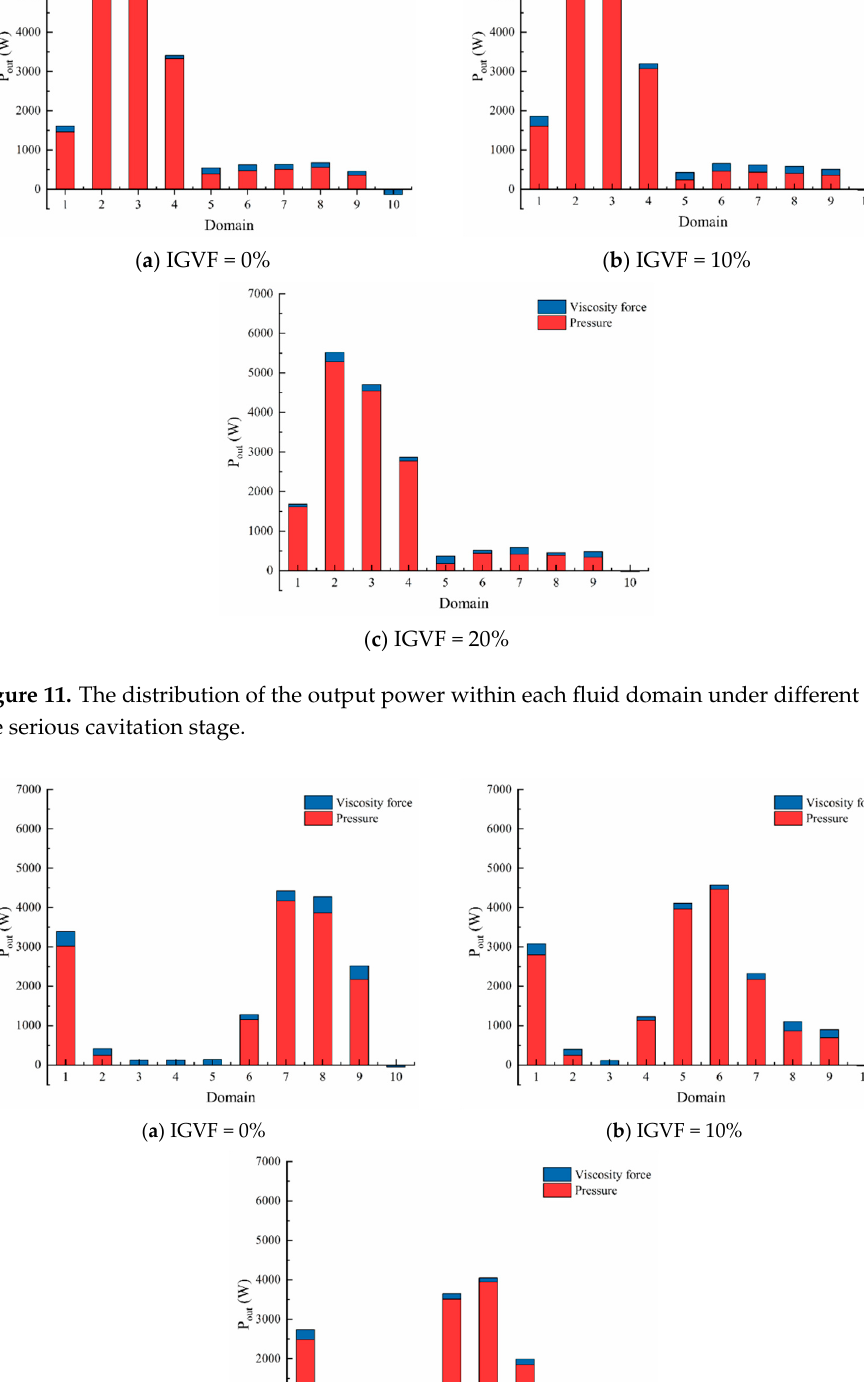
Figure 10. The distribution of the output power within each fluid domain under different IGVFs at the critical cavitation stage.